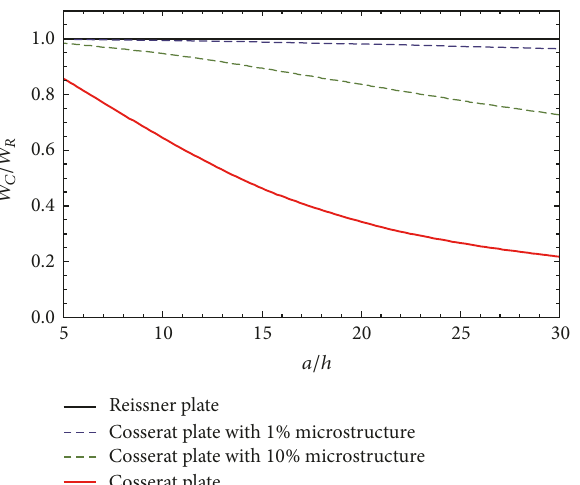
Figure 9: Comparison of the maximum vertical deflections of the circular Cosserat plate 𝑊 𝐶 with Reissner plate 𝑊 𝑅 for different values of width to thickness ratio 𝑎/ℎ , which illustrates the influence of the thickness of the Cosserat plate.